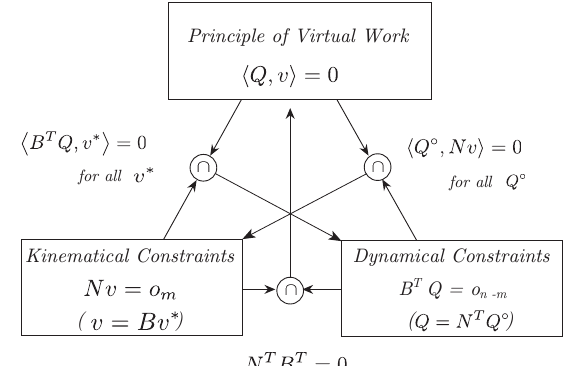
Figure 1. Duality